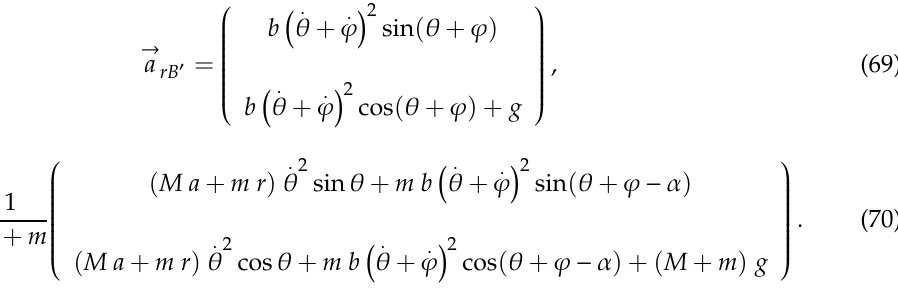
, θ ∗ , apparent periods T ∗ 5 1